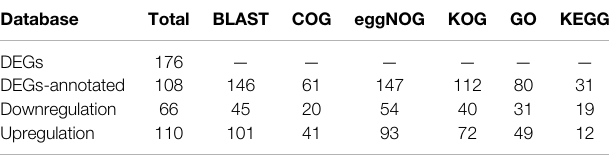
TABLE 1 | Statistics of the differentially expressed genes (DEGs).